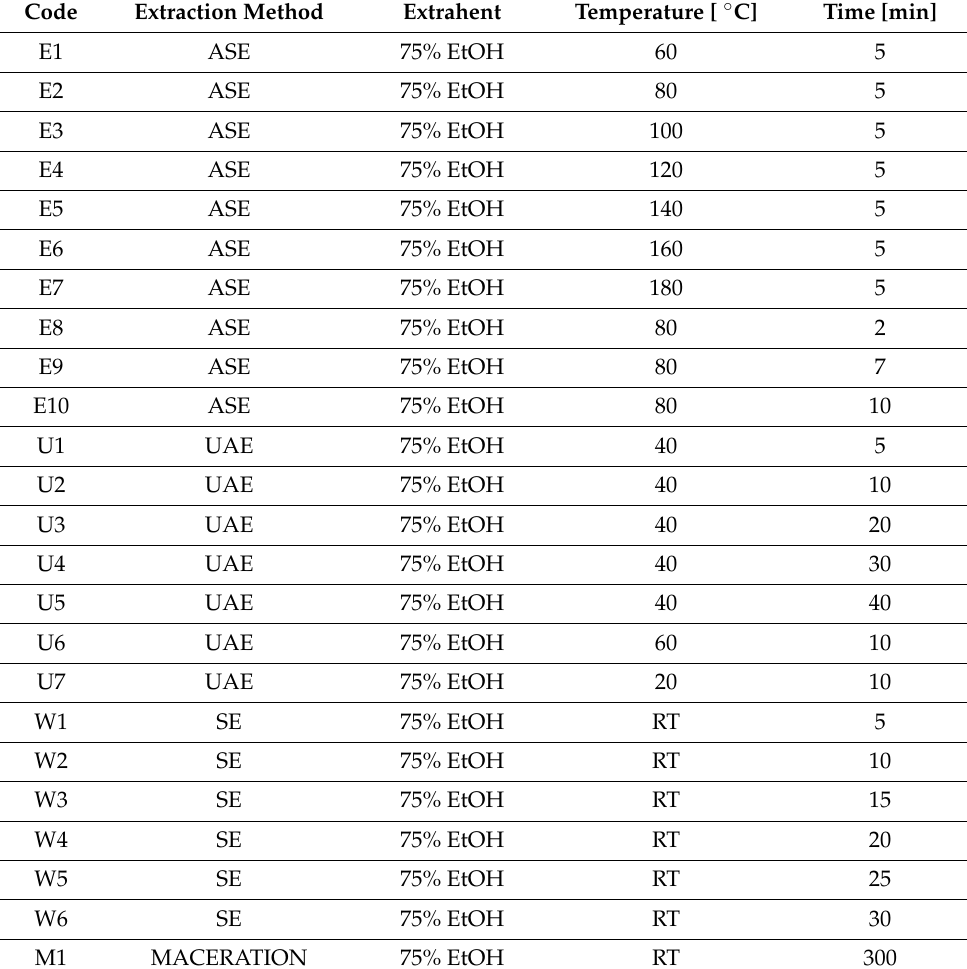
Table 2. Extraction conditions and DPPH scavenging activity of A. biebersteinii extracts (ASE— accelerated solvent extraction, UAE—ultrasound assisted extraction, M—maceration, SE—shaking extraction, RT—room